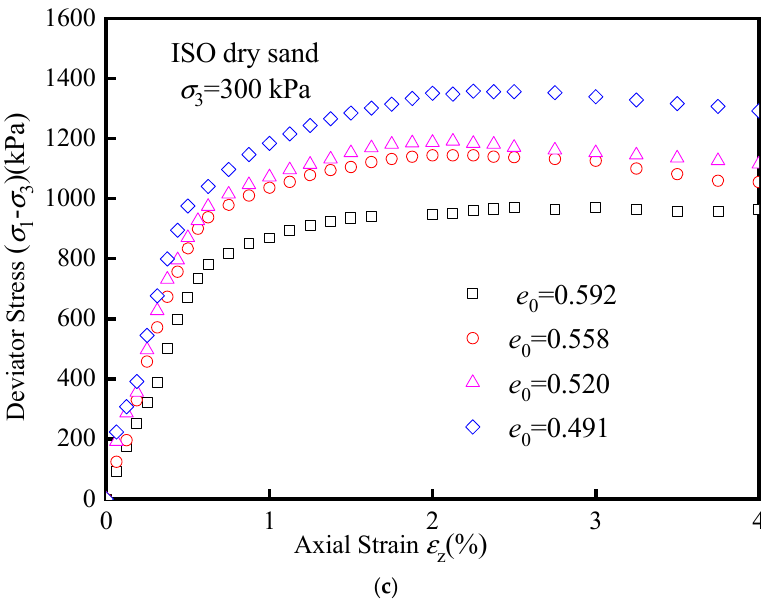
Figure 3. Deviator stress versus axial strain for the ISO dry sand in the undrained triaxial tests. ( a ) σ 3 = 100 kPa; ( b ) σ 3 = 200 kPa; ( c ) σ 3 = 300 kPa. Table 2. Experimental cases for the ISO sand.